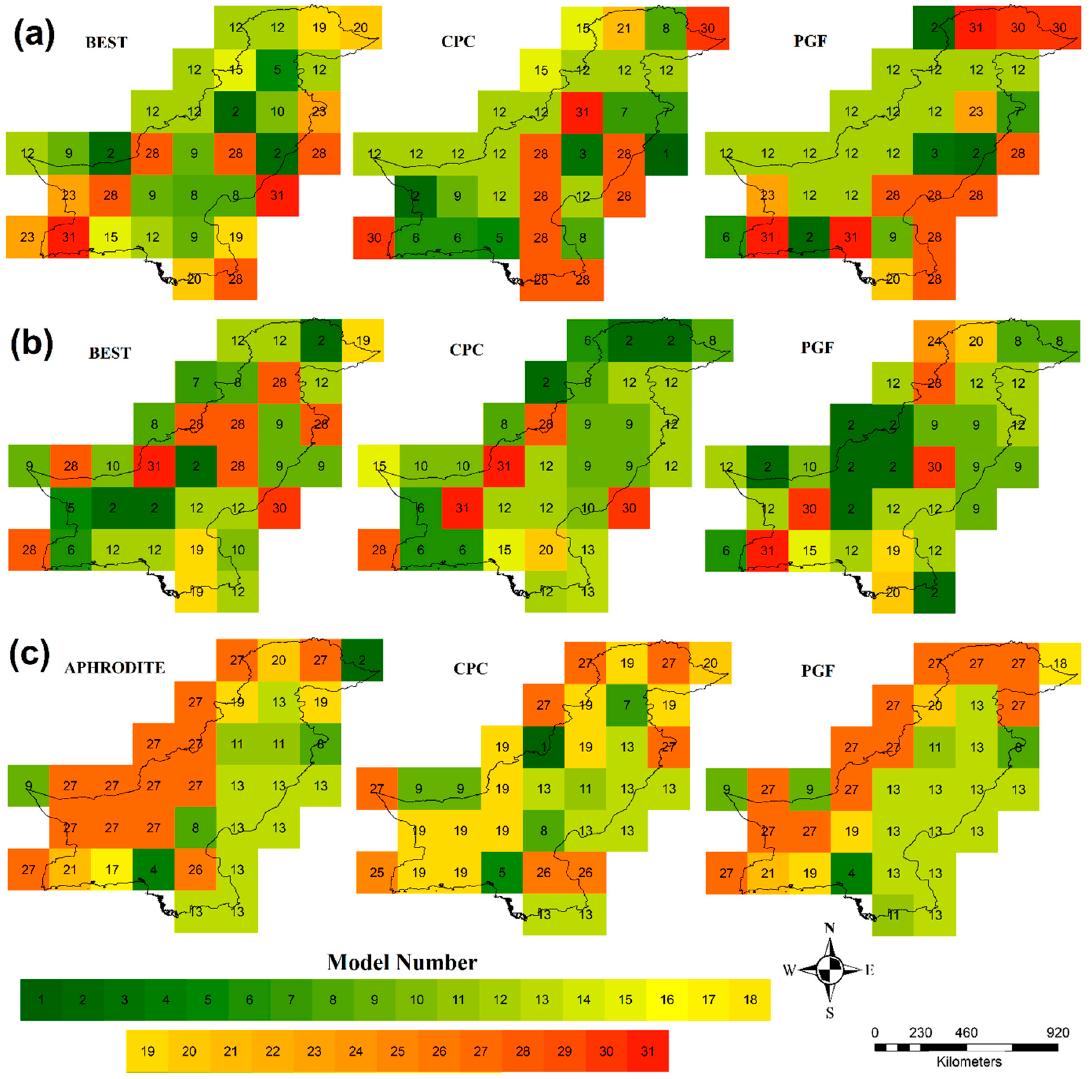
Figure 5. The geographical distribution of best performing GCMs in simulating: ( a ) maximum temperature; ( b ) minimum temperature; and ( c ) precipitation over Pakistan for different gridded datasets. The number in the figure represent the GCM as mentioned in Table 2.